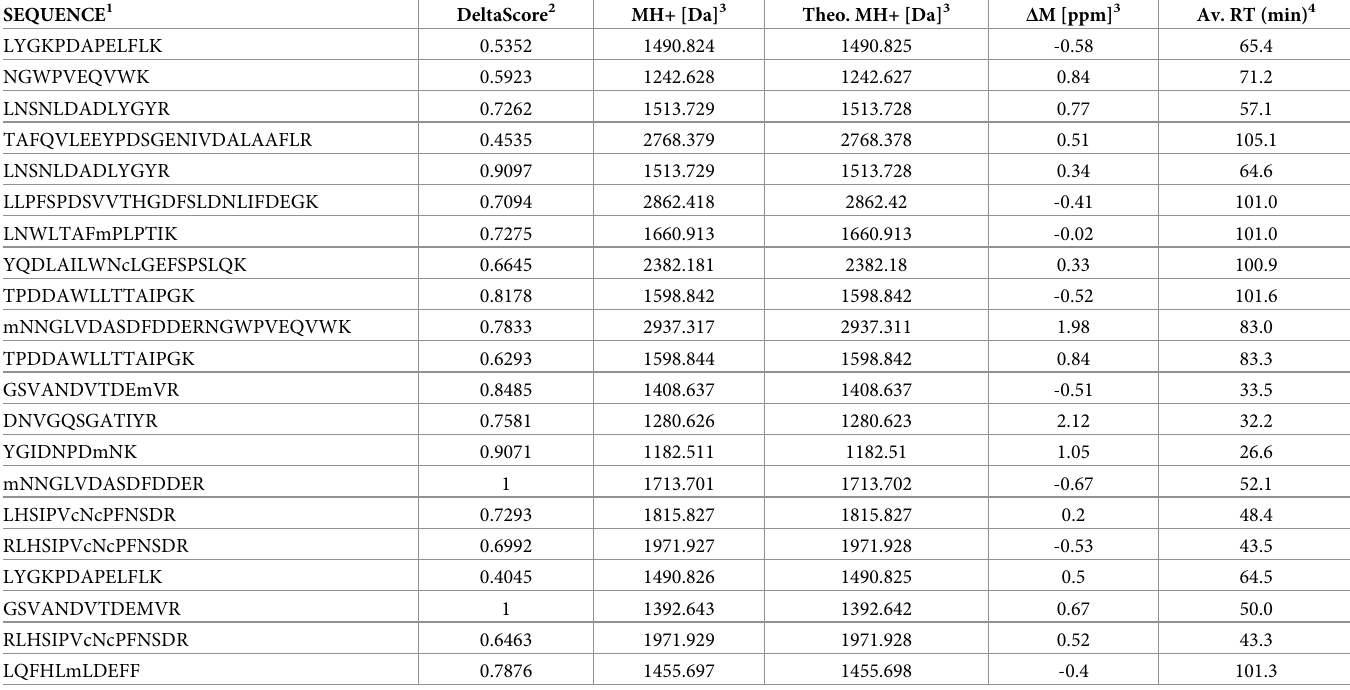
Table 2. Peptides identified by MS on the tprA ko -SS14 strain matching the Kan R protein sequence. SEQUENCE